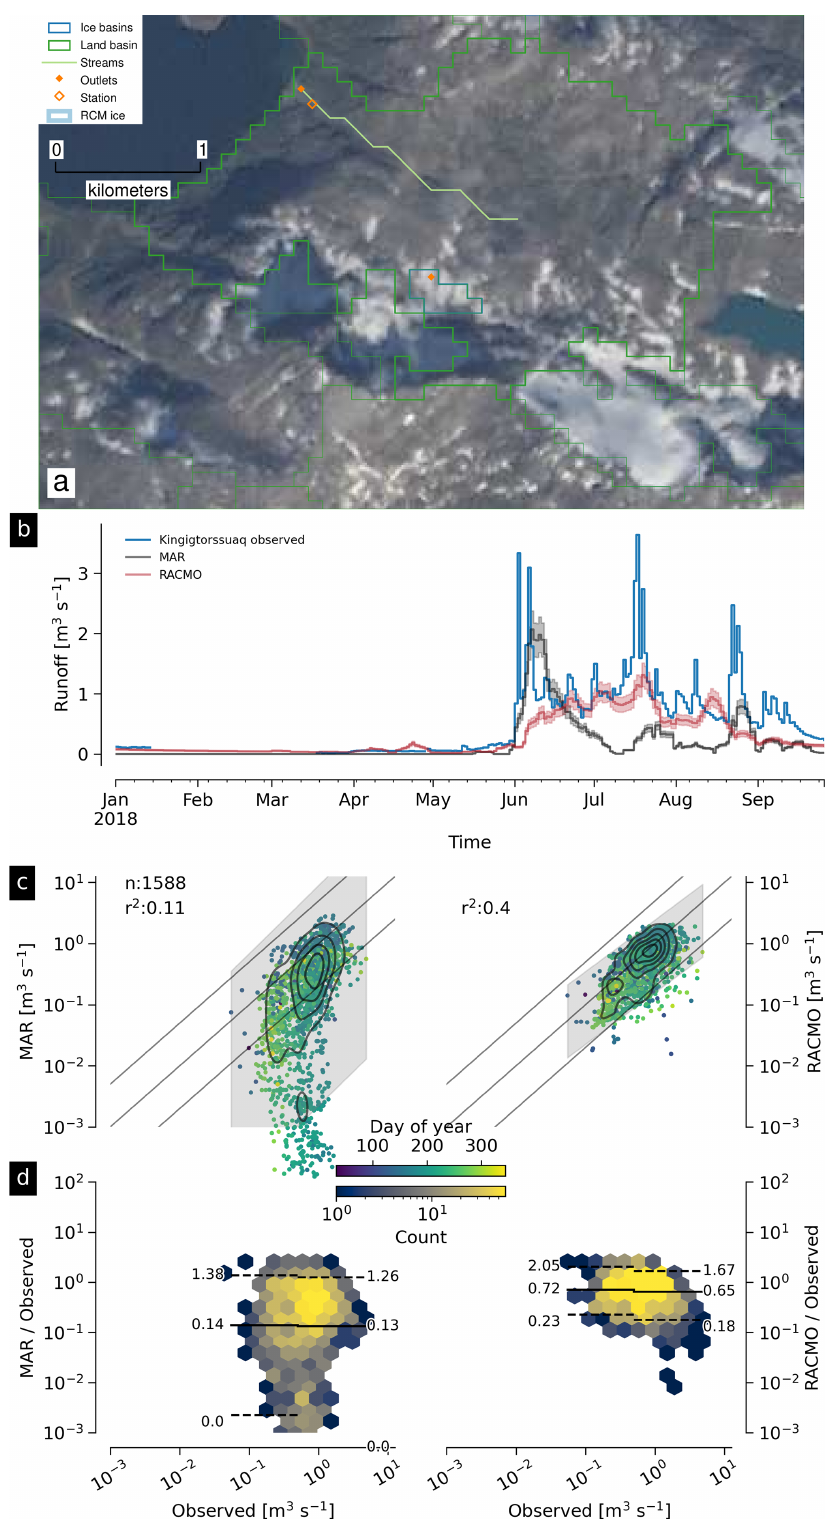
Figure 11. Graphical summary of Kingigtorssuaq outlet, basin, and discharge (K in Fig. 1). See Sect. 3.4 for a general overview of graphical elements and Sect. 4.2.5 for discussion of the Kingigtorssuaq basin. Basemap from Howat et al. (2014) and Howat